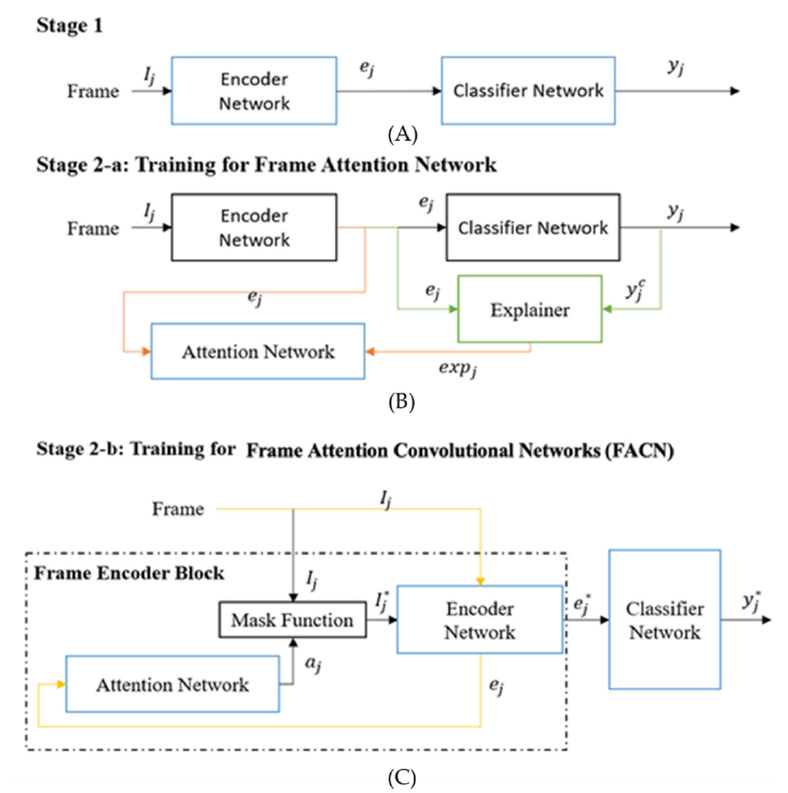
Figure 2 . First two training stages: ( A ) Stage 1, ( B ) Stage 2-a: Training for Frame Attention Network, ( C ) Stage 2-b: Training for Frame Attention Convolution Networks (FACN). Blue boxes indicate the